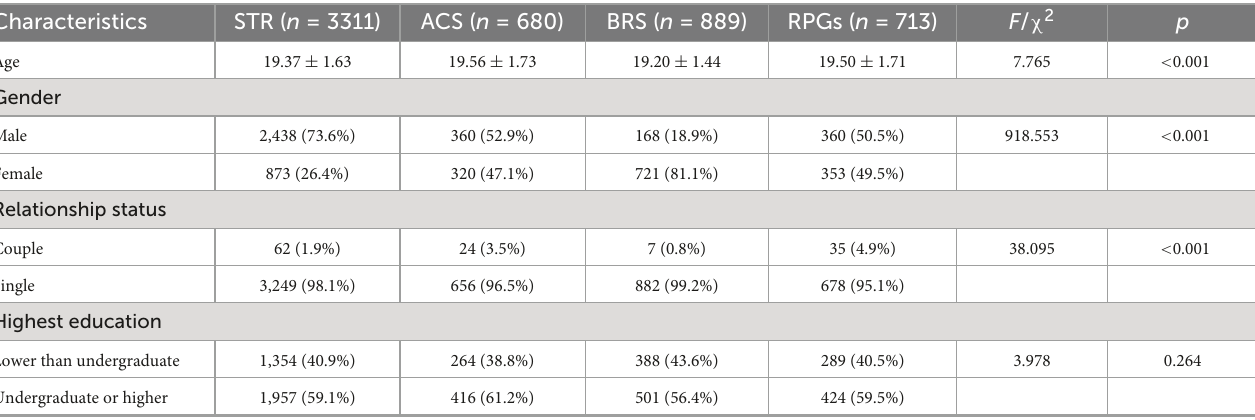
TABLE 1 Sociodemographic data.